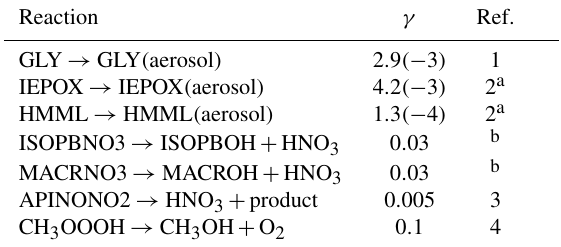
Table 4. Heterogeneous reactions on aqueous aerosols. γ denotes the reactive uptake coefficient. References: 1, Liggio et al. (2005); 2, Marais et al. (2016); 3, Fisher et al. (2016); 4, Müller et al. (2016). Reaction γ Ref. GLY → GLY ( aerosol ) 2 . 9 ( − 3 ) 1 IEPOX → IEPOX ( aerosol ) 4 . 2 ( − 3 ) 2 a HMML → HMML ( aerosol ) 1 . 3 ( − 4 ) 2 a ISOPBNO3 → ISOPBOH + HNO 3 0 . 03 b MACRNO3 → MACROH + HNO 3 0 . 03 b APINONO2 → HNO 3 + product 0 .